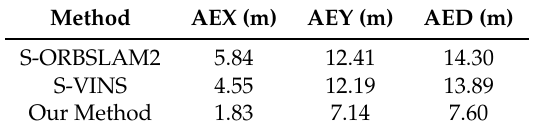
Table 4. Average Trajectories Errors of Varied Method in the Oxford RobotCar Dataset.